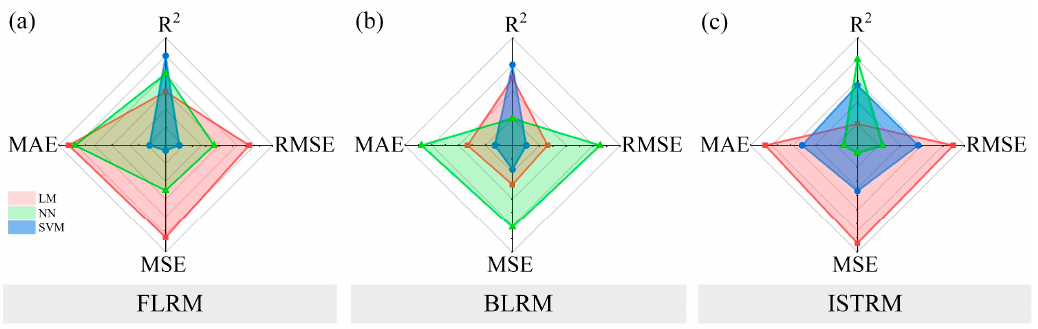
Figure 17. Performances of FL, BL, and IST regression models. ( a ) FLRM ( b ) BLRM ( c ) ISTRM.